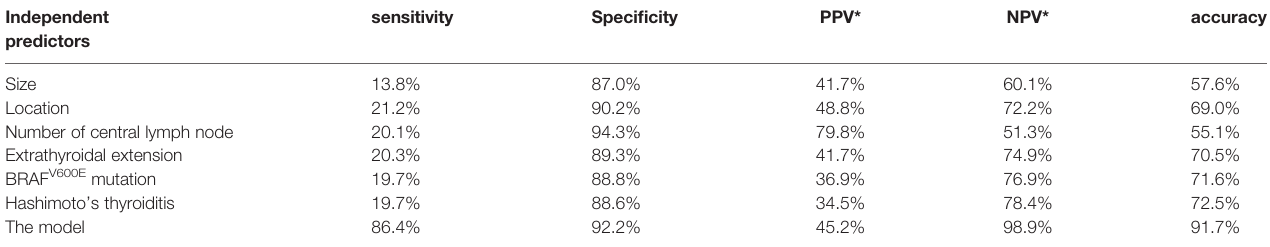
TABLE 5 | The predictive value for the model and independent predictors.